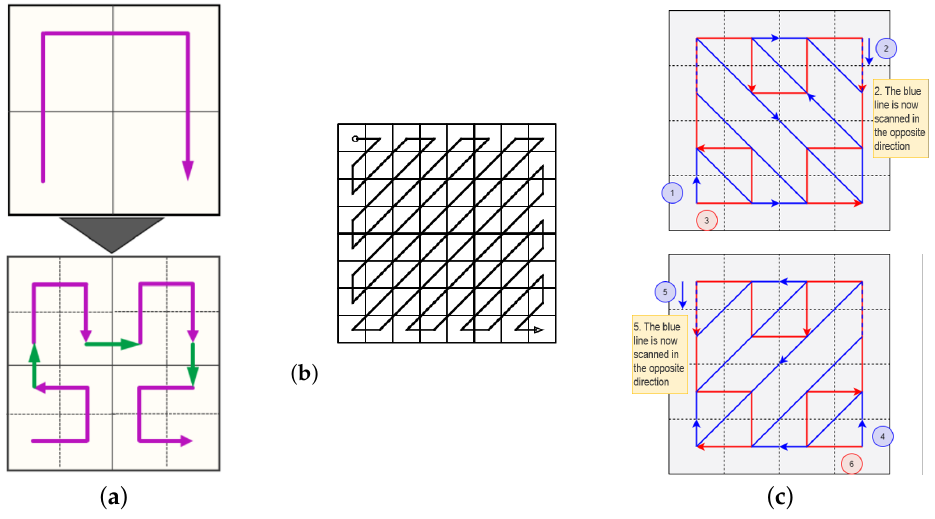
Figure 4. ( a ) Hilbert space-filling curve, ( b ) zig-zag scan, ( c ) symmetrized scan introduced for the second proposed algorithm through the combination of two Hilbert curve scans and four zig-zag